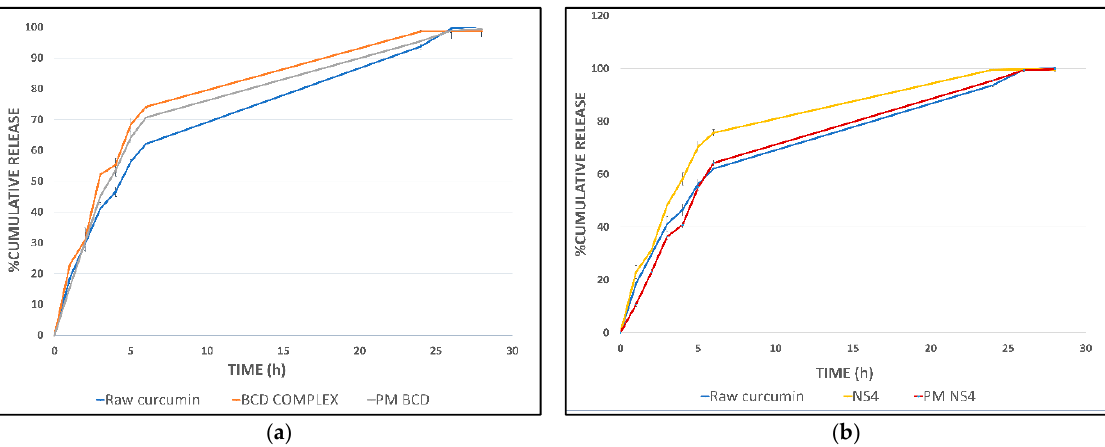
Figure 7. In vitro release profiles of ( a ) curcumin- β -cyclodextrin complex (BCD complex); ( b ) curcumin-loaded nanosponges (NS4) compared to the raw curcumin and the corresponding physical mixtures (PM BCD and PM NS4).